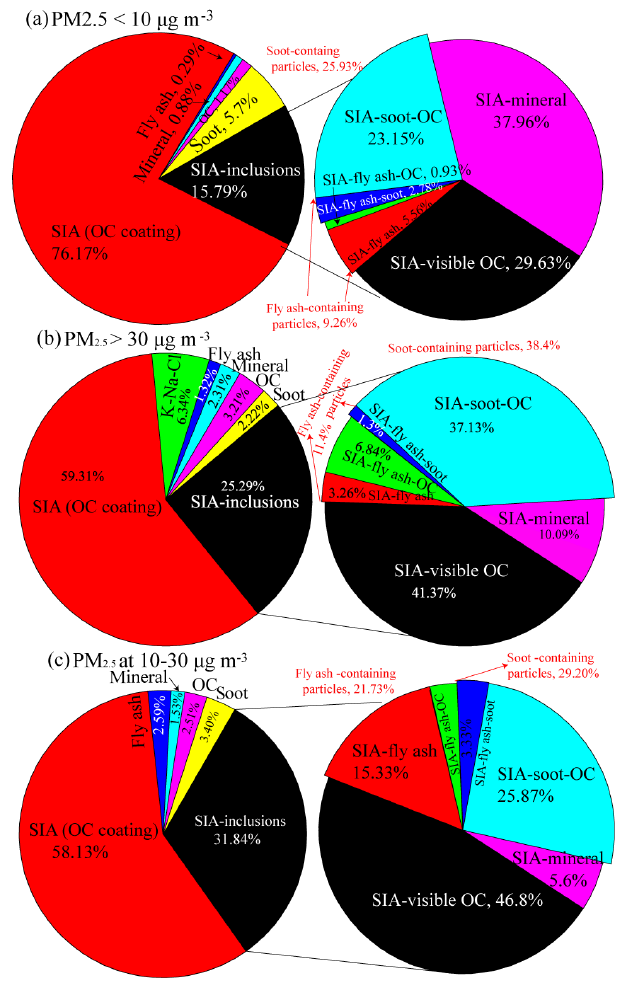
Figure 8. Identification of the pollution events based on individ- ual particle analysis. (a) 684 individual particles (left) and 108 SIA with inclusion particles (right). (b) 1214 individual particles (left) and 307 SIA with inclusion particles (right). Eight samples were collected in PM 2 . 5 larger than 30µgm − 3 induced by biomass burn- ing emission. (c) 2355 individual particles (left) and 750 SIA with inclusion particles (right). Nine samples were collected in PM 2 . 5 at the range of 10–30µgm − 3 induced by biomass burning and in- dustrial emissions. Four samples were collected with PM 2 . 5 smaller than 10µgm − 3 , which indicates clean